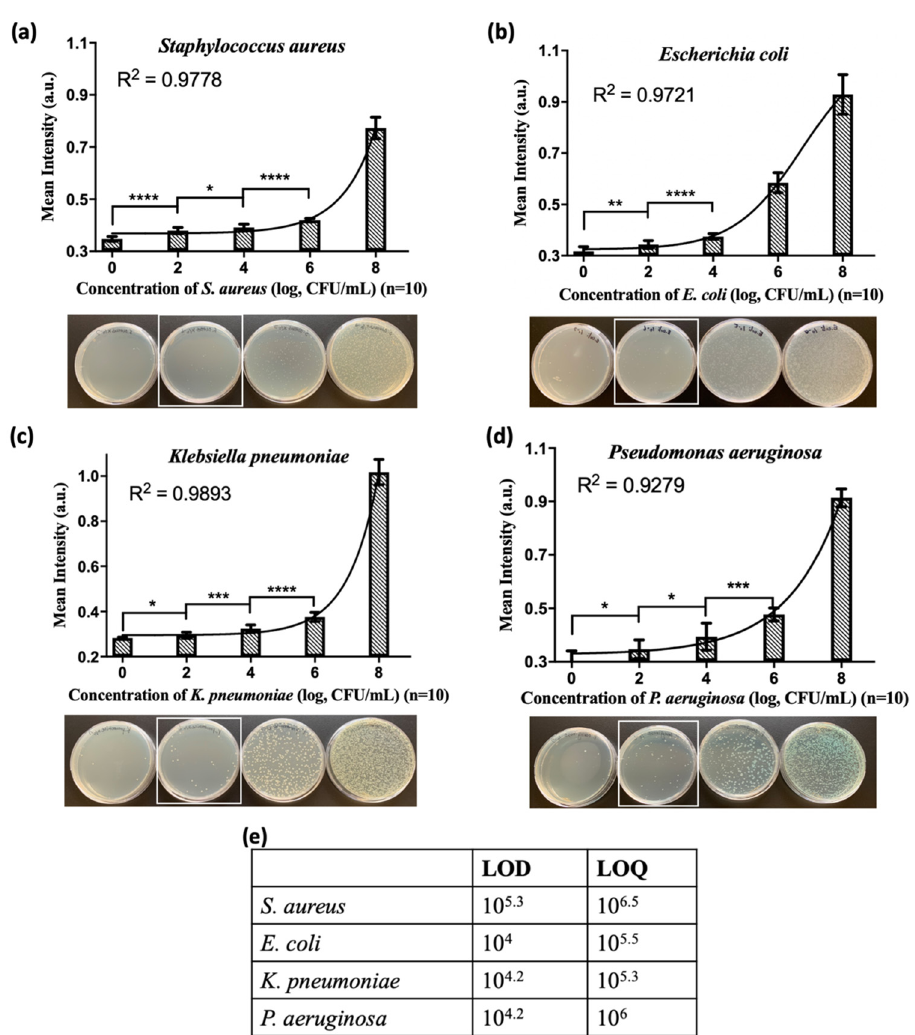
Figure 4. Detection capacity of the 3-(4,5-dimethylthiazol-2-yl)-2,5-diphenyltetrazolium bromide- phenazine methosulfate (MTT-PMS) assay for different bacterial species. The results were recorded using a microplate reader at 595 nm, and all experiments were repeated 10 times to ensure efficacy and reproducibility. Results of the MTT-PMS assay for: ( a ) S. aureus ; ( b ) E. coli ; ( c ) K. pneumoniae , and ( d ) P. aeruginosa . All assays demonstrated significant differences among the different bacterial concentrations. (* p < 0.05, ** p < 0.01, *** p < 0.001, **** p < 0.0001); ( e ) Limit of detection (LOD) and limit of quantification (LOQ) of the MTT-PMS assay in a buffer system for different species as calculated using Hill’s